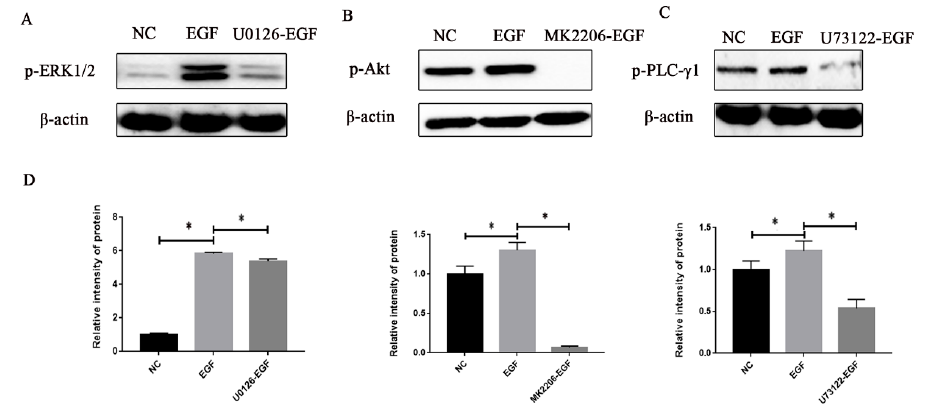
Figure 5. Effect of the protein inhibitor on signal protein activities in GMECs. ( A ) GMECs were treated with 500 nM MK2206 (Akt inhibitor) for 60 min and then stimulated with 50 ng / mL EGF for 60 min, to investigate the phosphorylation level of Akt. ( B ) GMECs were treated with 10 µ M U0126 (MEK inhibitor) for 60 min and then stimulated with 50 ng / mL EGF for 60 min, to investigate the phosphorylation level of ERK1 / 2. ( C ) GMECs were treated with 20 µ M U73122 (PLC- γ 1 inhibitor) for 15 min and then stimulated with 50 ng / mL EGF for 60 min, to investigate the phosphorylation level of PLC- γ 1. ( D ) The band intensity was shown by Image J software. Values are presented as means ± SD of three independent experiments. * Means p <